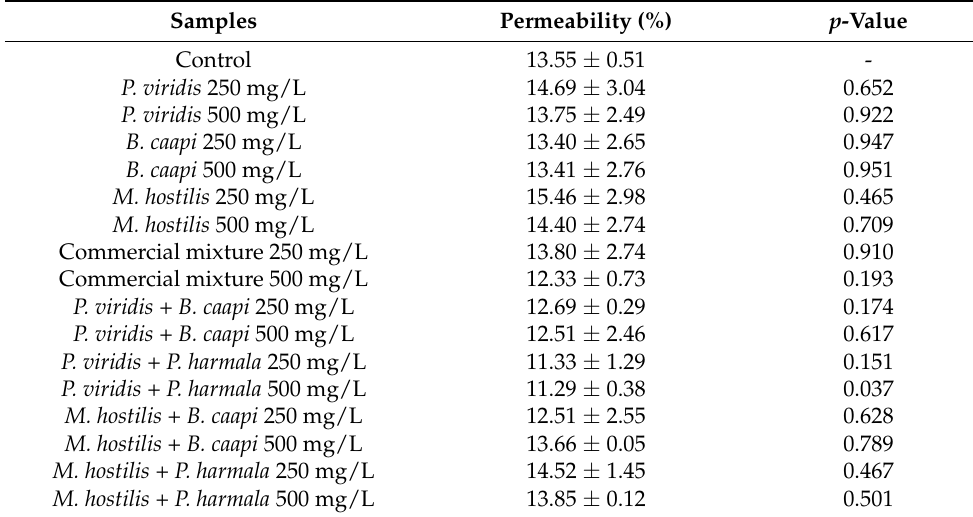
Table 5. Percentage of permeability of NHDF cells after incubation with the extracts. The values are expressed as mean ± SD. Statistically significant values were considered if p <